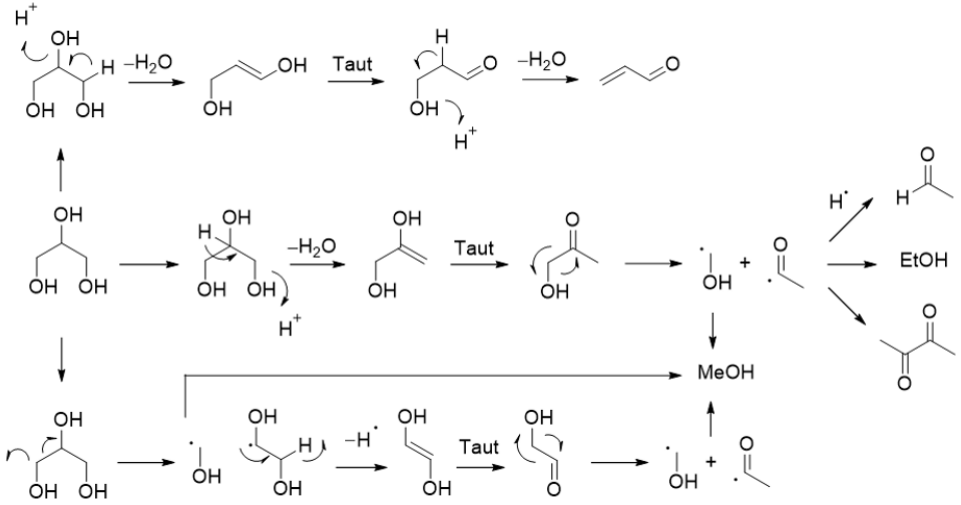
Scheme 13. One-step low-pressure process production of